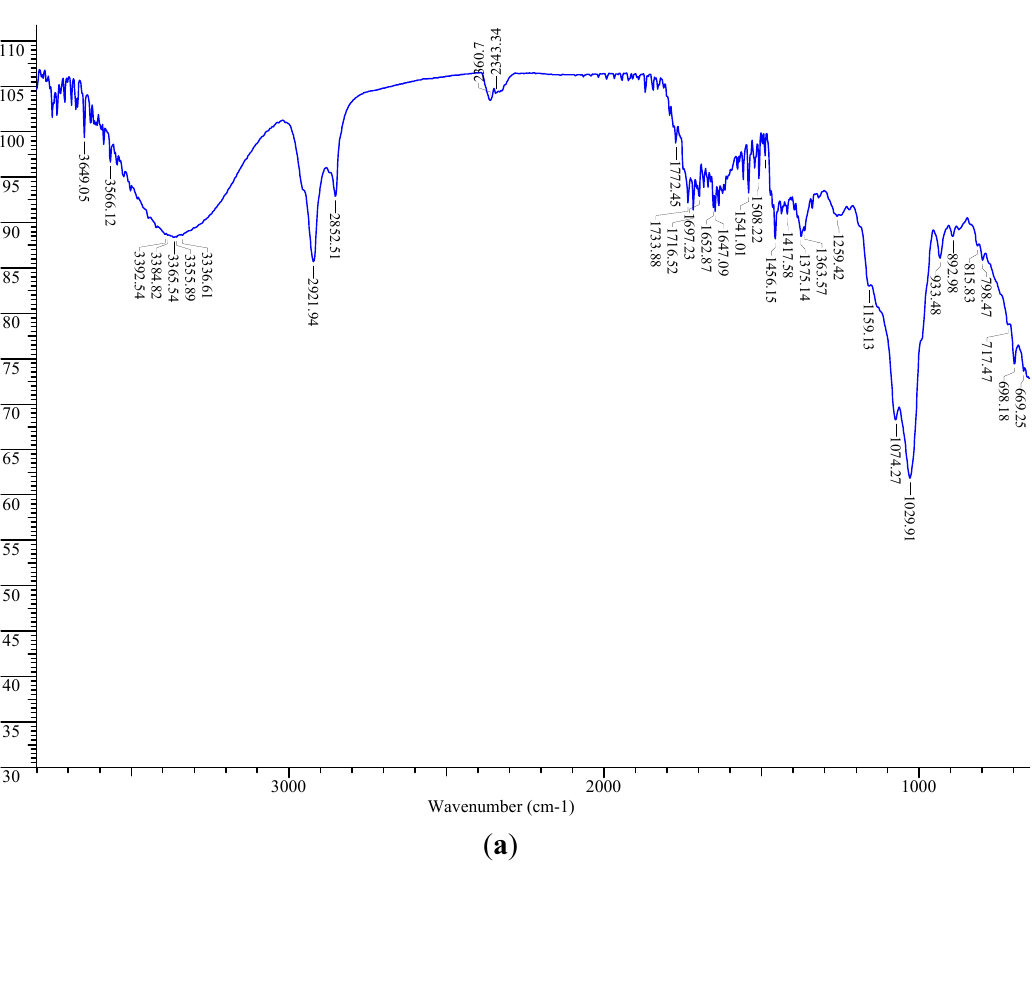
Figure 2. ( a ) FT-IR spectra of chloroform extract. ( b ) FT-IR spectra of ethyl acetate extract. ( c ) FT-IR spectra of ethanol extract. ( d ) FT-IR spectra of aqueous